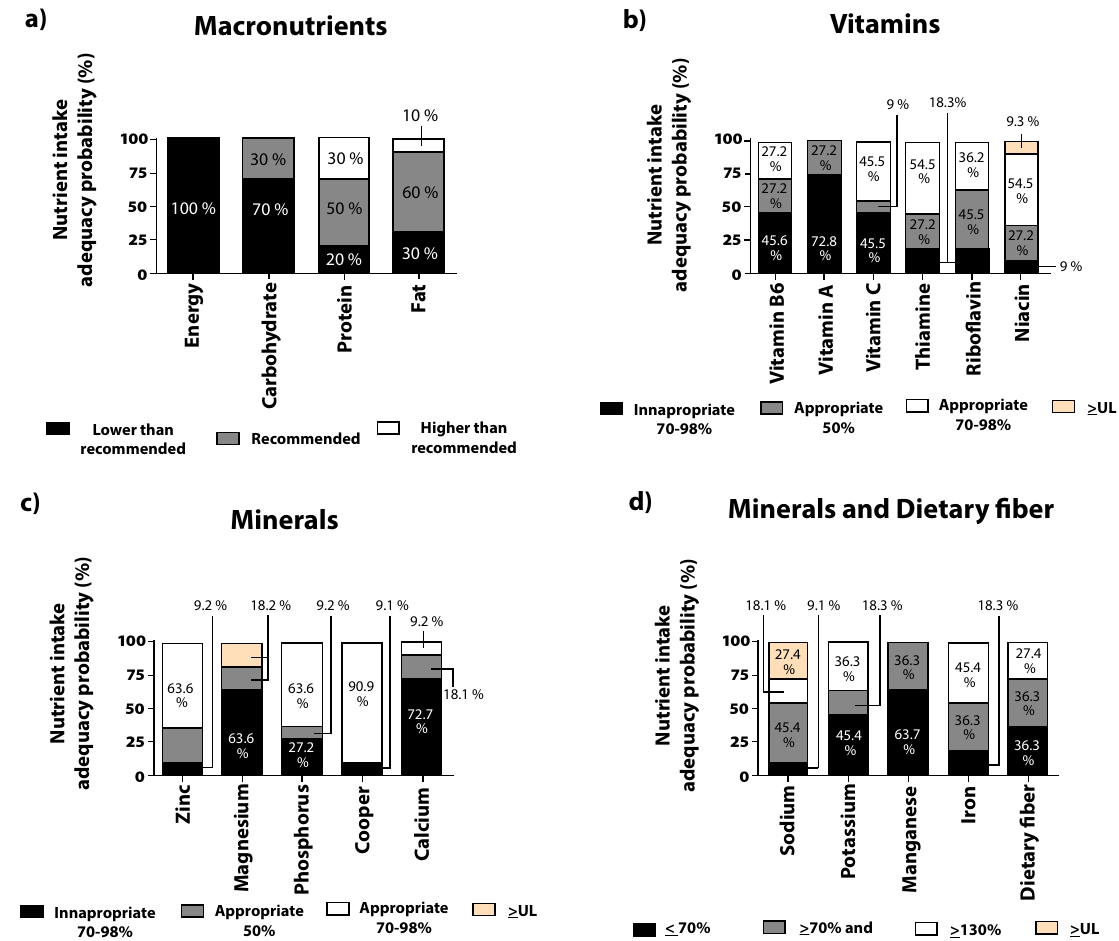
Figure 1. Athletes’ food intake valuation; a) Daily energy and macronutrient consumption, obtained over three days and compared with the American Dietetic Association, Dietitians of Canada and American College of Sports Medicine; b) Vitamin intake adequacy probability accord - ing to the dietary record over three days; c) and d) Minerals intake adequacy probability according to the dietary record over 3 days and fiber food consumption obtained over 3 days. All columns represent the percentage of athletes in each